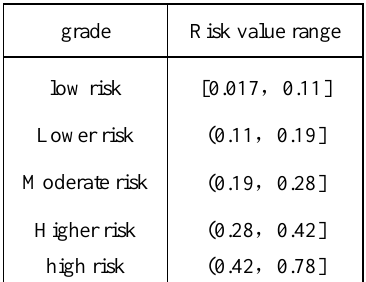
Table 2. Comprehensive Ecological Risk Classification Table